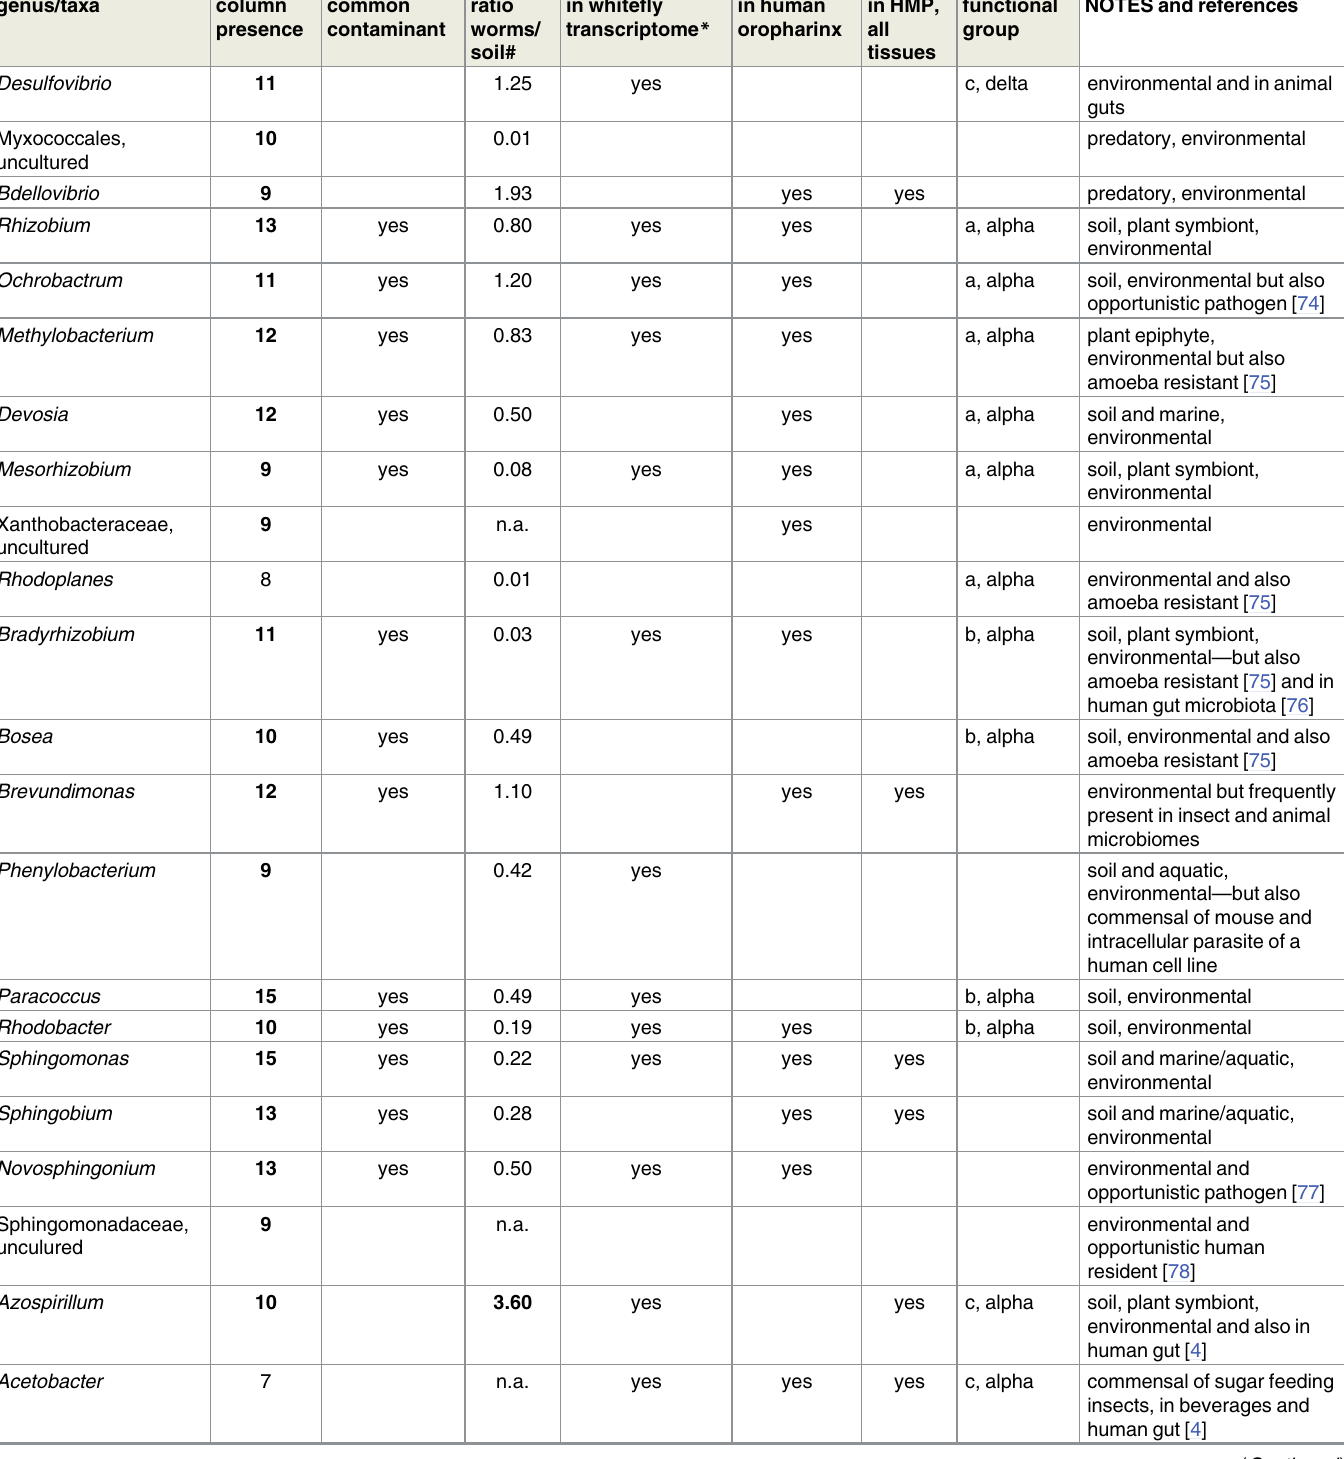
Table 3. The table lists the 40 most common taxa found in the microbiomes of arthropods and their properties [74–84].